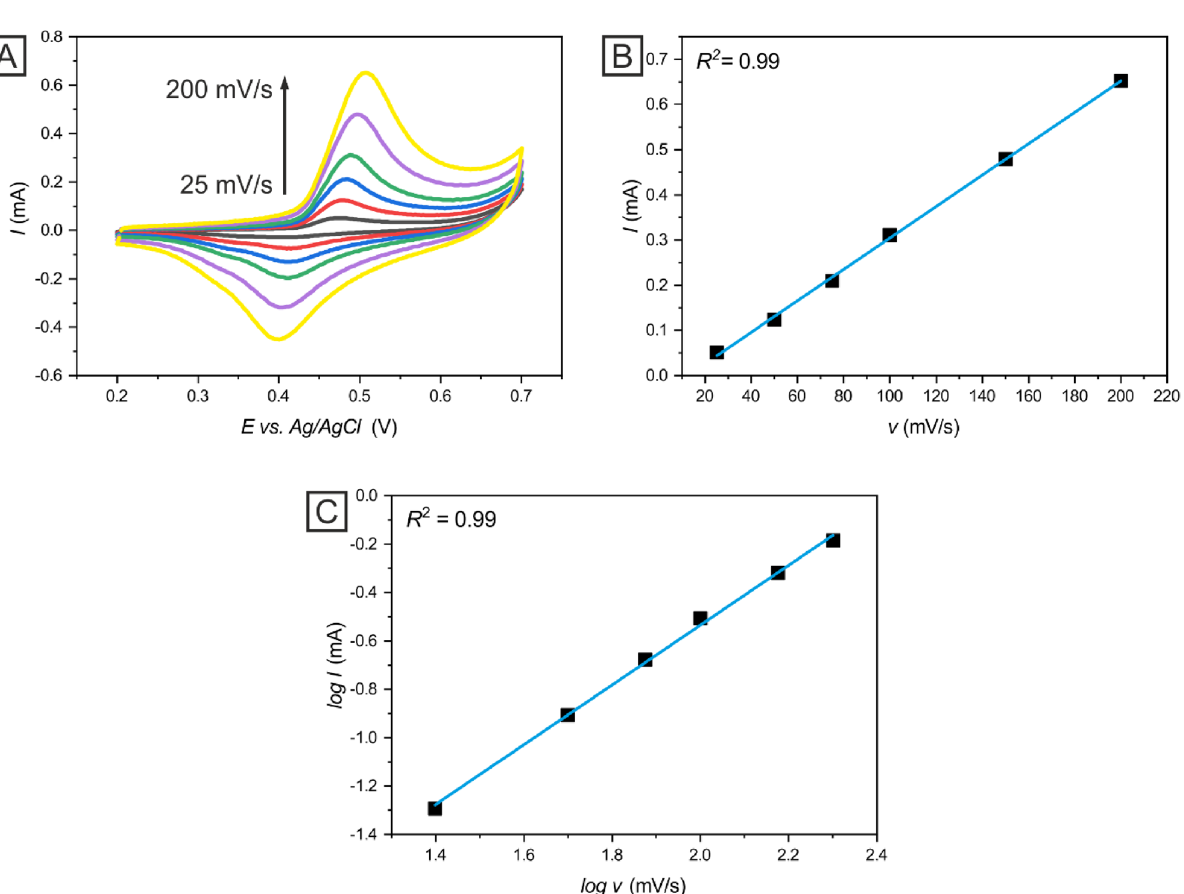
Figure 6. Cyclic voltammograms of 2 × 10 –6 mol dm −3 insulin on Ni-c-ITO at different scan rates ( A (25 mV s − to 200 mV s −1 )). The dependency of peak current on the scan rate ( B ) and the dependence of peak current of log I on log v ( C